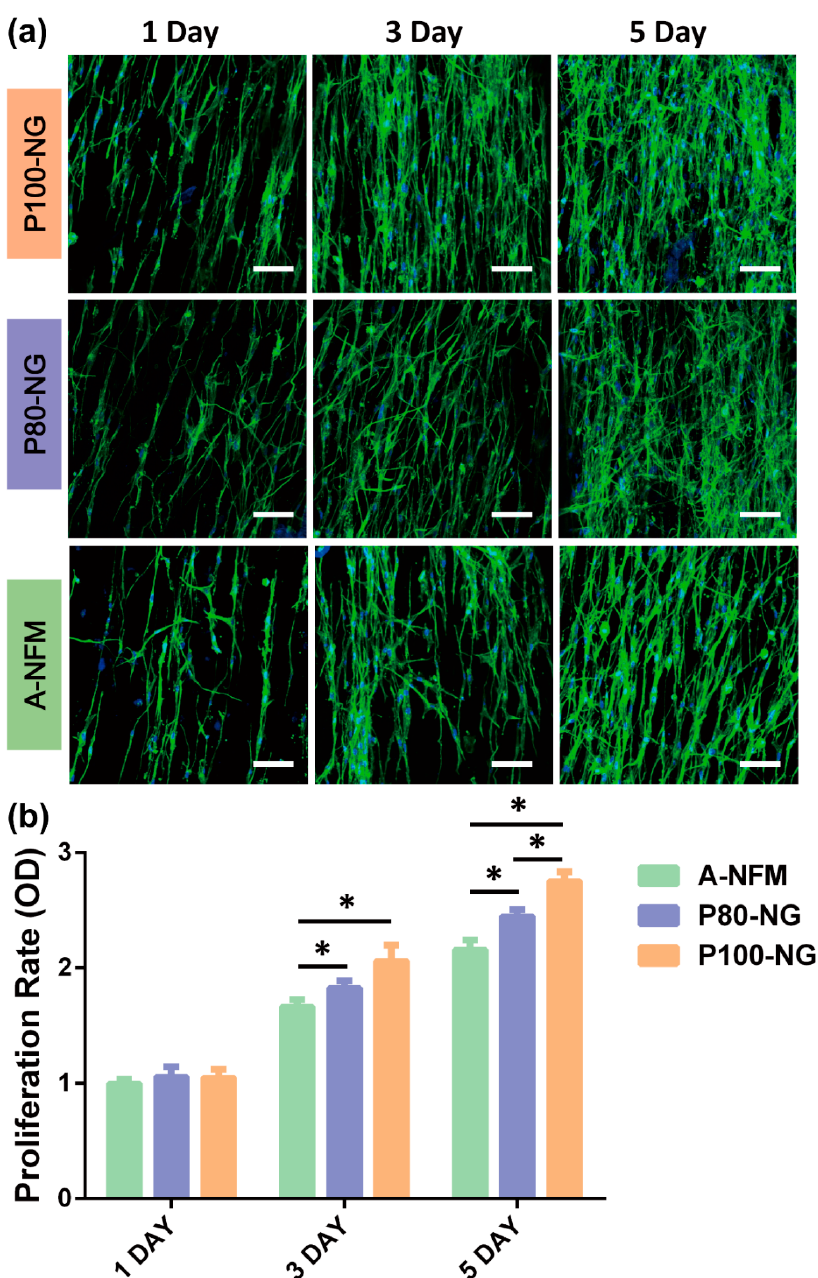
Figure 8. Proliferation of MC3T3 cells on P80-NG, P100-NG, and control A-NFM. ( a ) Fluorescence microscopy images of MC3T3 cells on A-NFM, P80-NG, and P100-NG. ( b ) MC3T3 cells proliferation analyzed by ImageJ software after 1, 3, and 5 days culture. All data represent the mean standard deviation ( n = 3, * p < 0.05). The scale bar is 100 µ